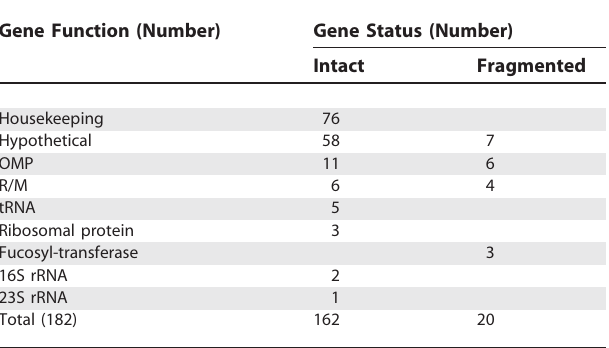
Table 3. Genes in the Sheeba Genome Flanking 91 Genomic